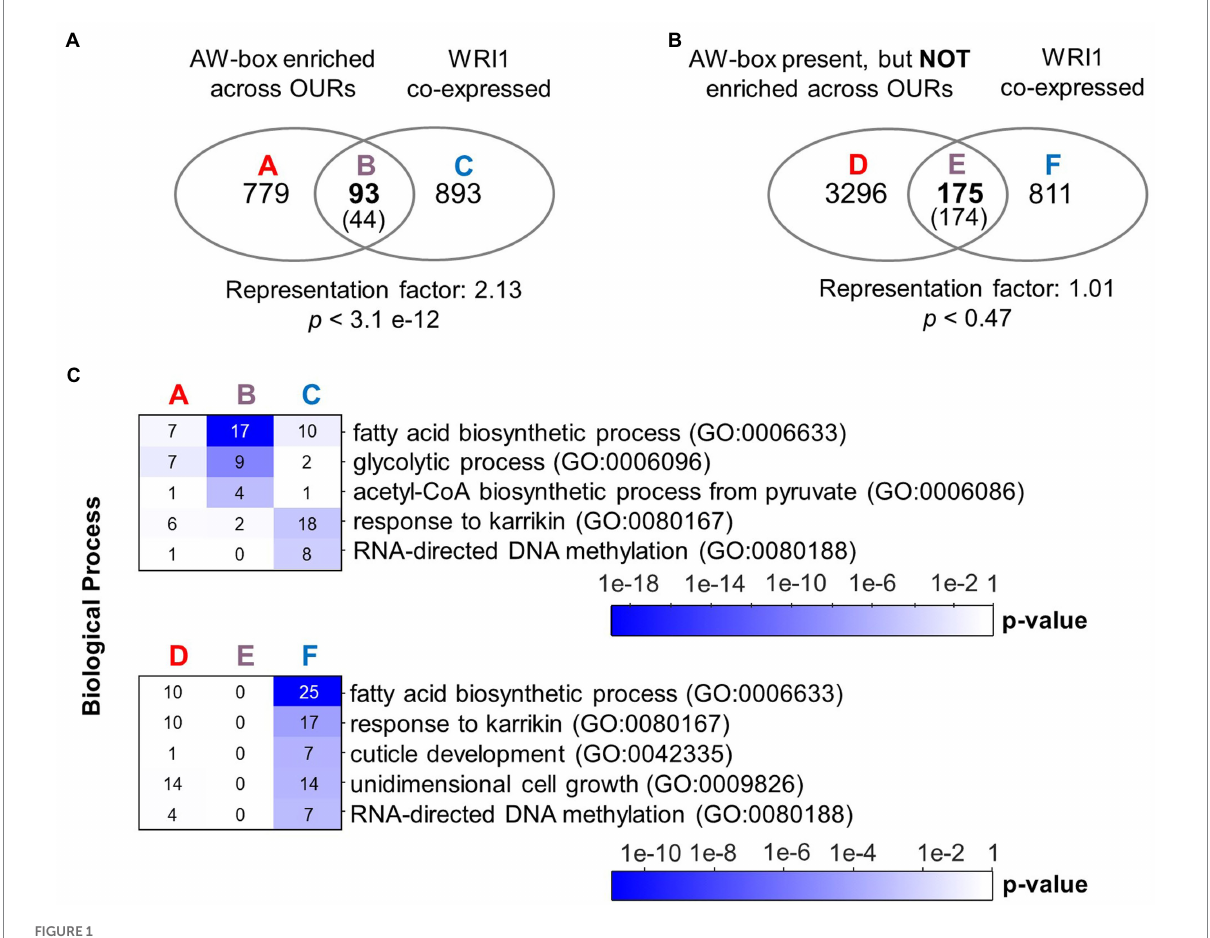
FIGURE 1 Overrepresentation of the AW-box across orthologous upstream regions identifies likely WRI1 gene targets. (A) Overlap of A. thaliana genes with AW-box enriched across OURs and genes that are found to be co-expressed. In the intersect, expectation values are shown in parentheses. Statistical significance is indicated by hypergeometric p value. (B) Venn diagram like panel A, but considering only genes for which the AW-box is present upstream A. thaliana genes but not enriched across OURs. (C) Overrepresentation of GO biological processes among sets A to E is shown in panels A and B. Numbers on the heat maps are gene counts. A seed development transcriptomic dataset of Schneider et al. (2016) was mined (see methods). Co-expressed genes are defined by a cutoff for the Pearson correlation coefficient ( R -value) of 0.943. Similar results are obtained for a range of threshold values tabulated in Supplementary Table 11. GO term analysis was performed using the DAVID version 6.8 online resource (https://david.ncifcrf.gov/; Huang da et al., 2009). Abbreviation: OUR, orthologous upstream